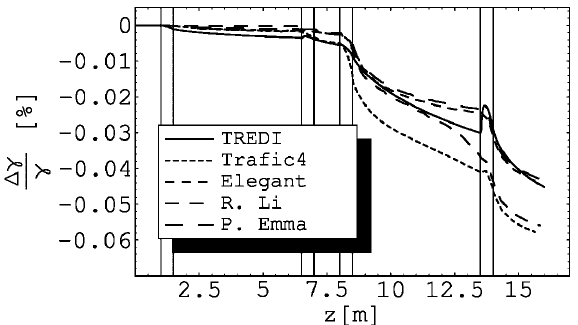
FIG. 14. Relative beam energy versus average bunch longitu- dinal coordinate along the beam line. The vertical lines mark the positions of each bending edge. All results obtained with codes other than TREDI are from the ICFA Zeuthen Workshop web site [19]. Some manipulation was required to adapt the data to be shown in the same